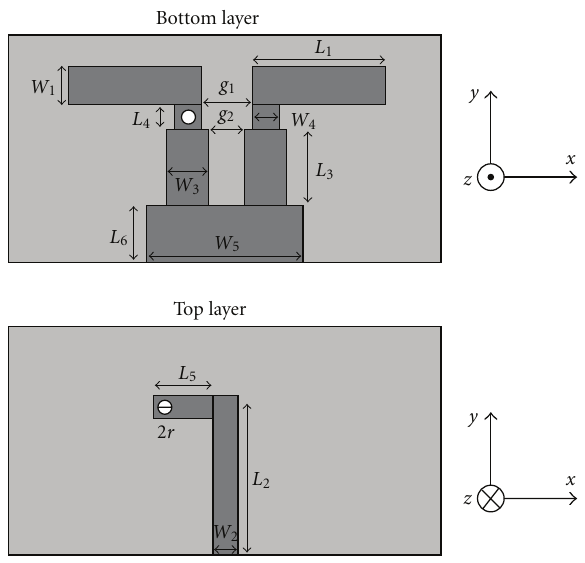
Figure 1: Geometry of printed